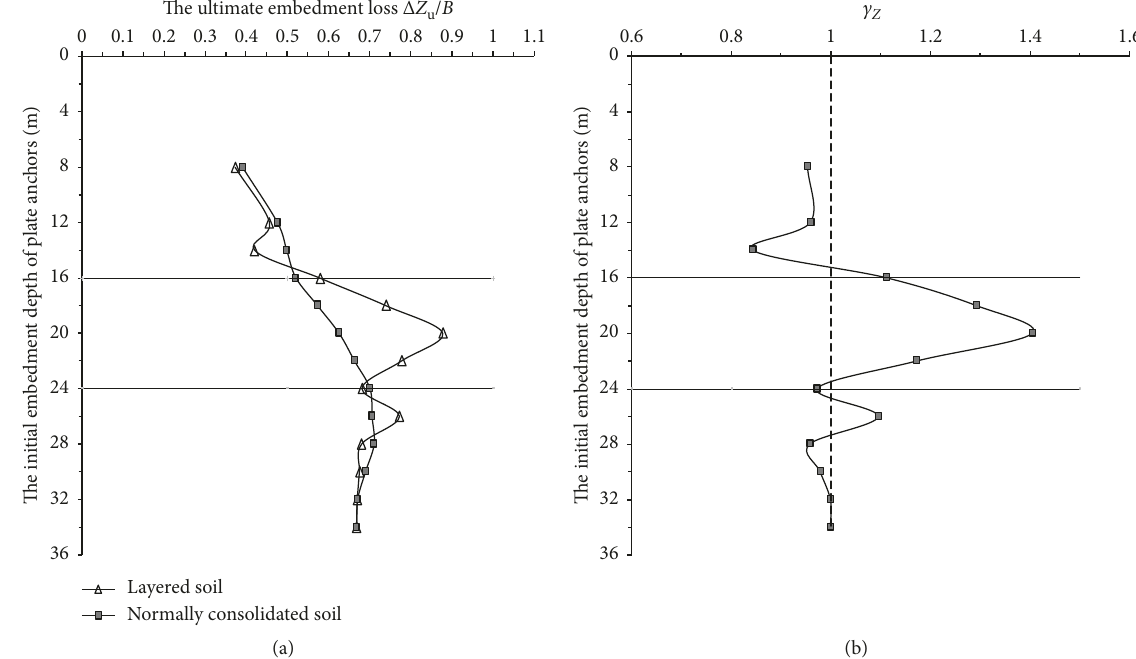
Figure 12: Comparison of the ultimate embedment loss in layered soil and normal consolidated soil: (a) effect of initial embedment depth on the ultimate embedment loss; (b) effect of layered soil on the embedment.